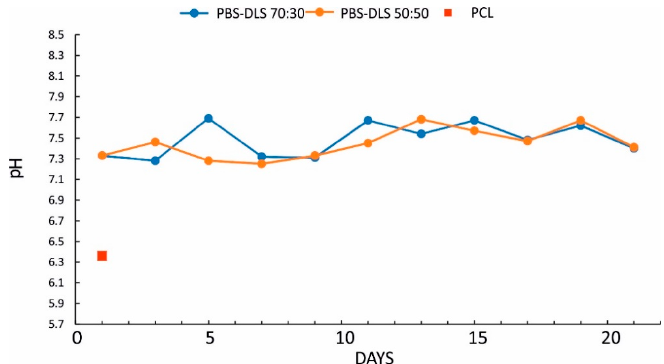
Figure 4. Changes in the pH of degradation media during degradation for PBS-DLS 70:30, PBS DLS 50:50, and PCL films.